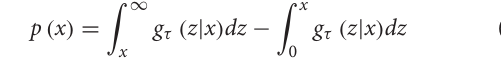
Figure 1B . The contour maps provide the top views of the three- dimensional graphs. Thus, each vertical intersection of a contour map at period t denotes a probability density function, showing the transition probabilities from a particular RDIPC value at period t to another value at period t + 1 . For cities situated on the diagonal line, the RDIPC levels will remain the same before and after the